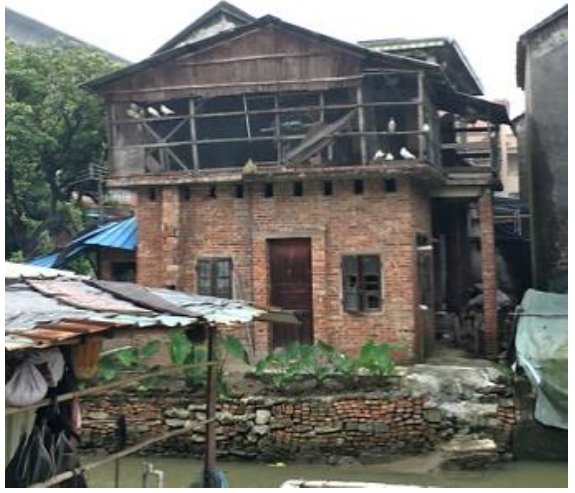
Figure 12. Wood mould in the making (Source: The authors).